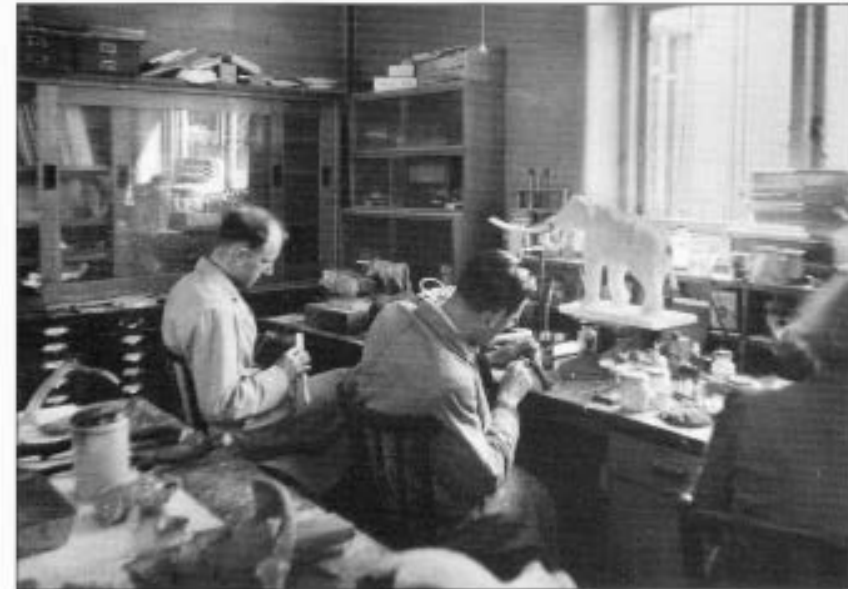
Figure 3 Part of the Institute's laboratory at St John's Lodge, Regent's Park, in the late 1940s or early 1950s, showing two students seated infrontoftwo of the models: a straight­ tusked elephant (centre) and a (smaller) aurochs [left).